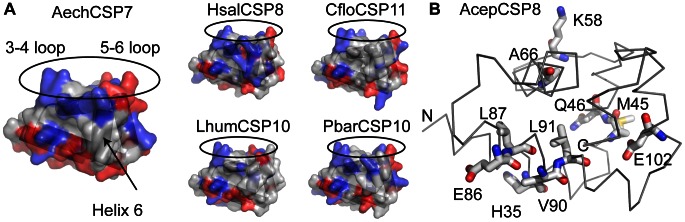
Ant-specific CSPs share similarities with CSP7, and positive selection in them is concentrated on the surface.(A) Left, molecular model of CSP7 shows a “crown” of charged residues (circled). The crown is formed by the positive loop between helices 3 and 4, and by the negative charge between helices 5 and 6. The ant-specific proteins (right) all have this crown. Positively charged residues (K, R) are shown in blue and negatively charged (D, E) in red. (B) The ten residues under positive selection (shown as sticks on the peptide backbone) mostly map on the surface. L87 and L91 are the only binding residues under positive selection. K58 and A66 are located near the “crown” and have various combinations of positive charge and hydrophobicity in the ant-specific CSPs. The N and C termini are indicated.